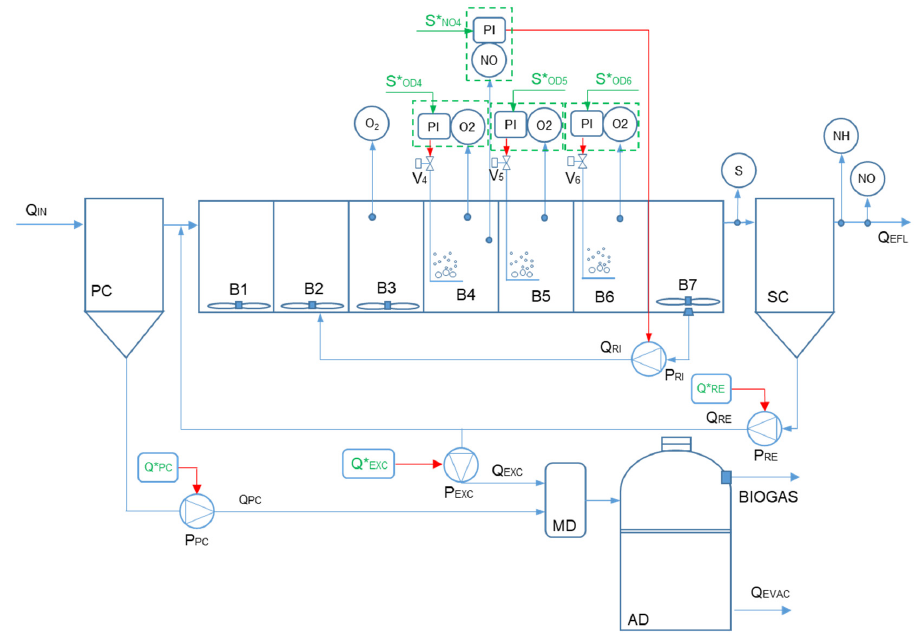
Figure 2. Schematic representation of a treatment line together with the automation equipment.